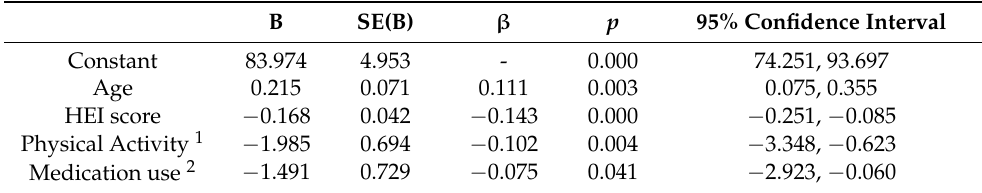
Table A1. Multiple linear regression model of predictors of waist circumference in White post- menopausal women ( N =